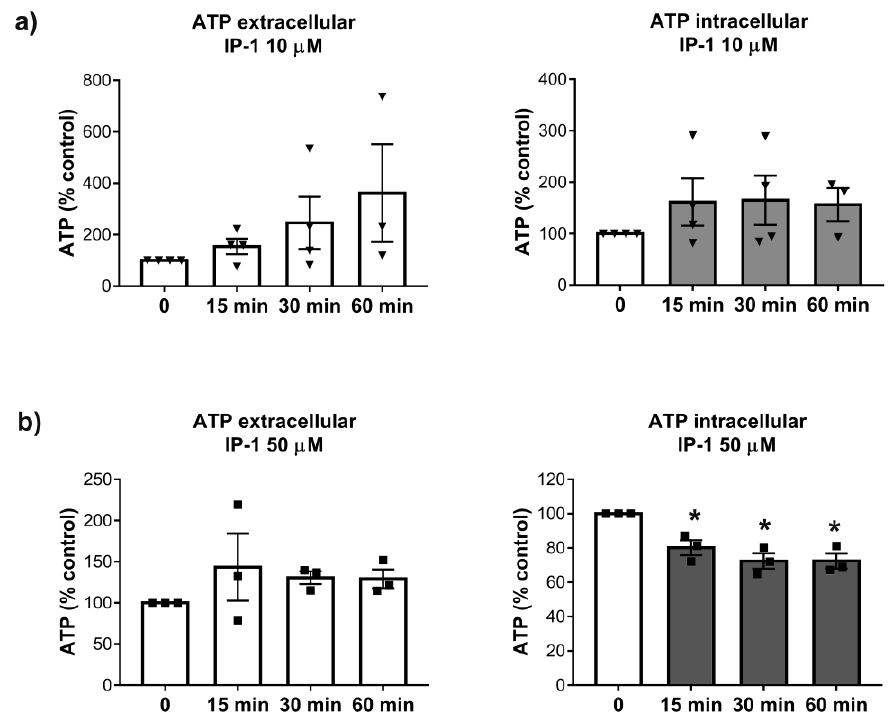
Figure 3. Intra and extracelullar ATP levels of HEK293T cells treated with PI-1. Upper panel ( a ) shows the extra (left) and intracellular (right) ATP levels of HEK293T cells exposed at IP-1 10 μM. Lower panel ( b ) shows the extracellular (left) and intracellular (right) ATP levels of HEK293T cells exposed at IP-1 50 μM. The image was generated using R package. Each plot represents the normalized ATP levels of 4 different experiments on HEK293T cells (see Materials and Methods). Each symbol (Triangles, squares) represent an independent determination. Asterisk represents statistical significance p < 0.05 with respect to measurements at time 0.